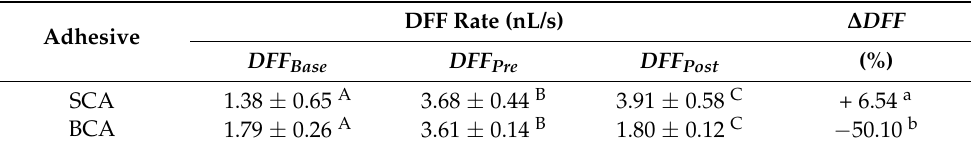
Table 4. Average dentinal fluid flow (DFF) rate and reduction rate (n = 5).